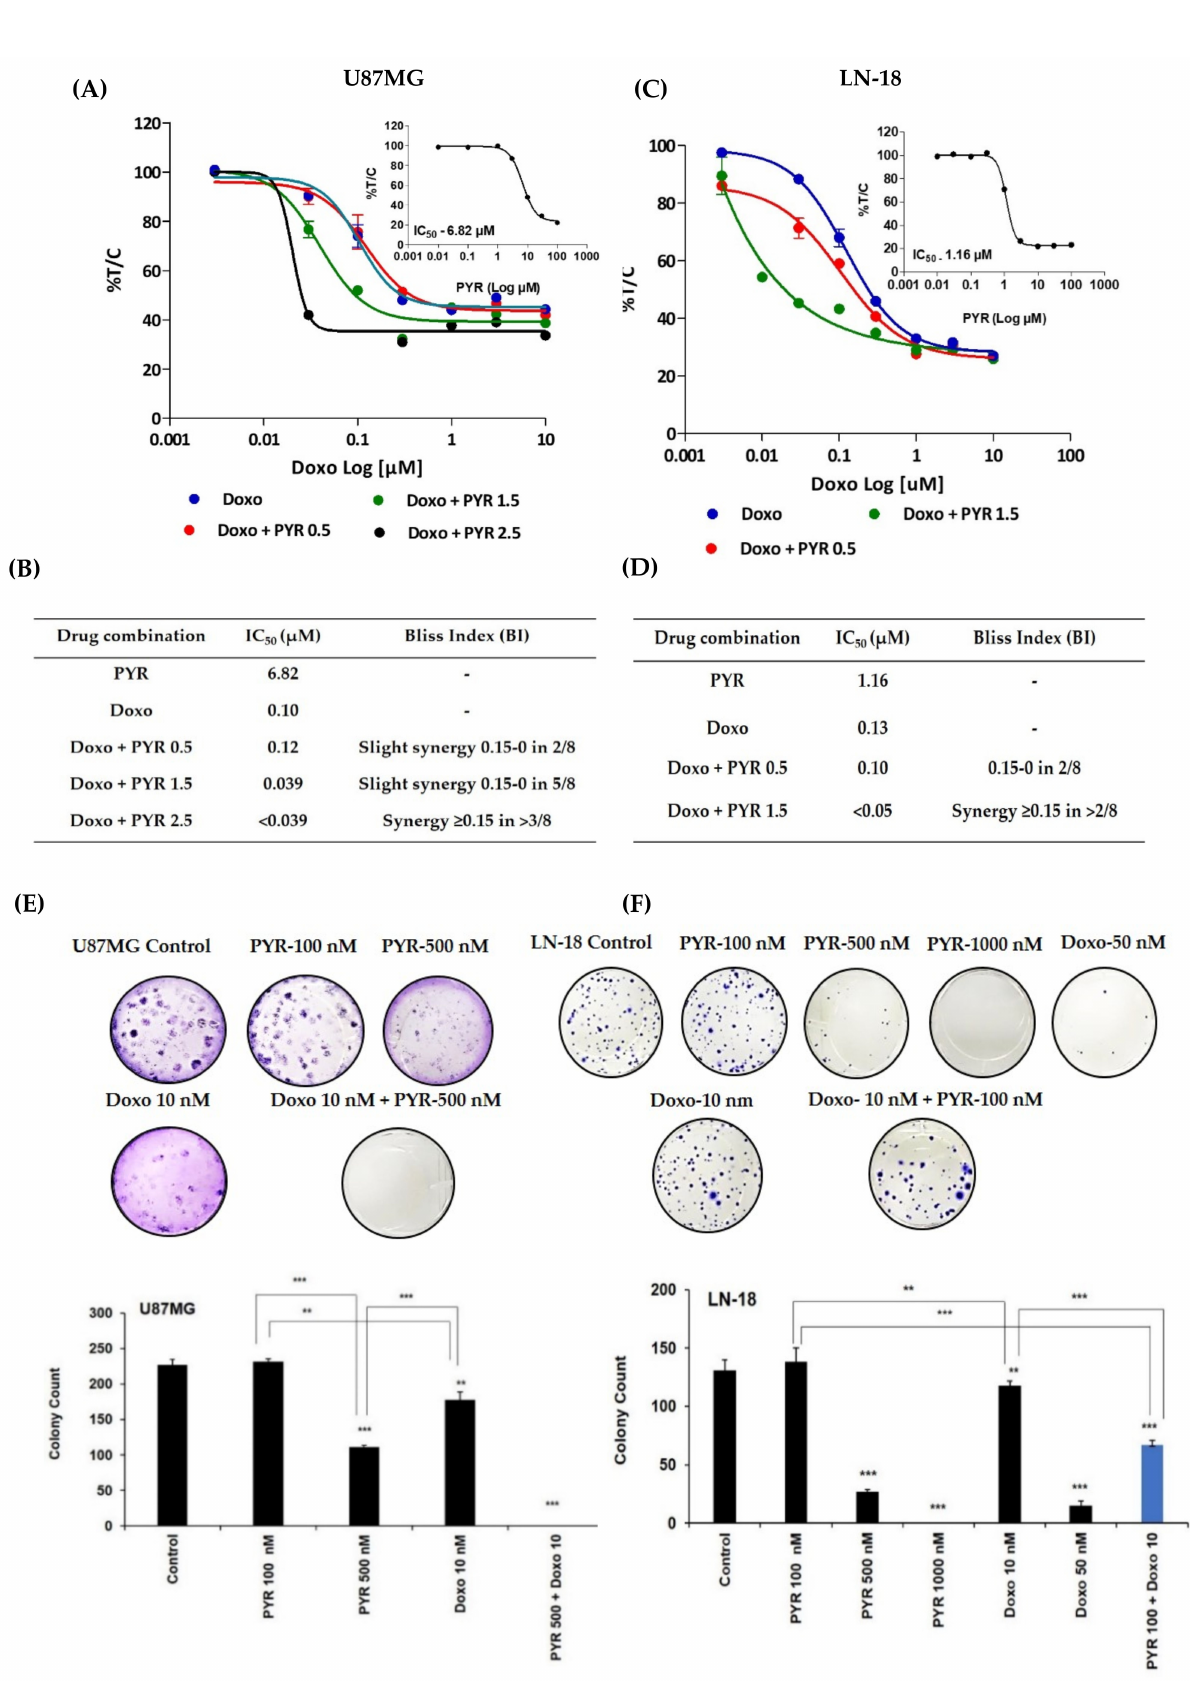
Figure 4. ( A , C ) Sigmoidal curve for combination treatment in U87MG and LN-18 cells at indicated concentrations for 72 h. Treatment with PYR at different concentrations with Doxorubicin shifts